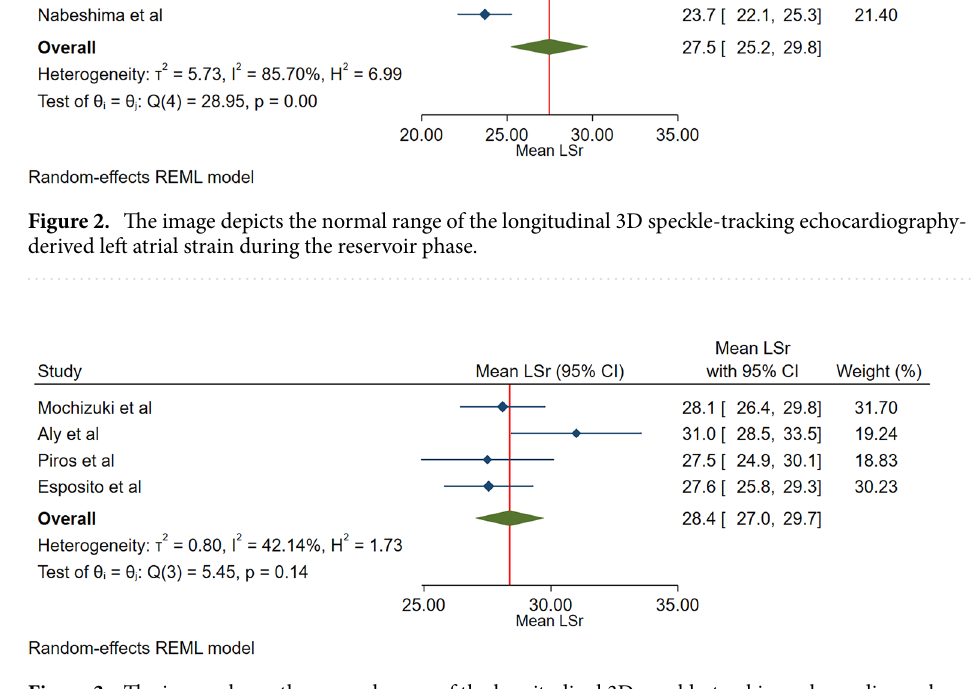
Figure 3. The image shows the normal range of the longitudinal 3D speckle-tracking echocardiography- derived left atrial strain during the reservoir phase analyzed by Toshiba